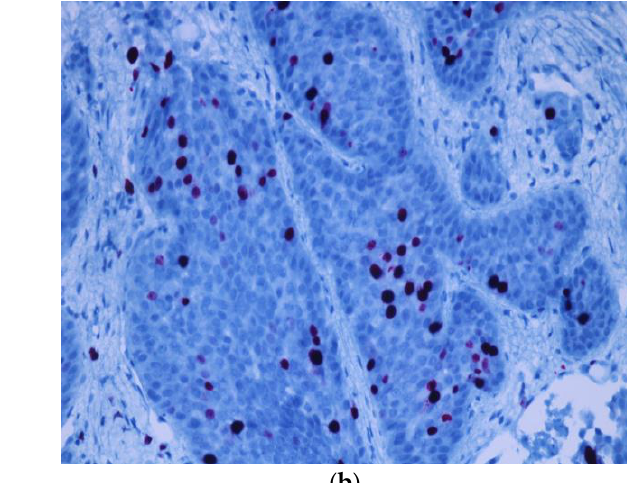
clavicular, mediastinal, and retroperitoneal lymph nodes, as well as liver and bone metastases.